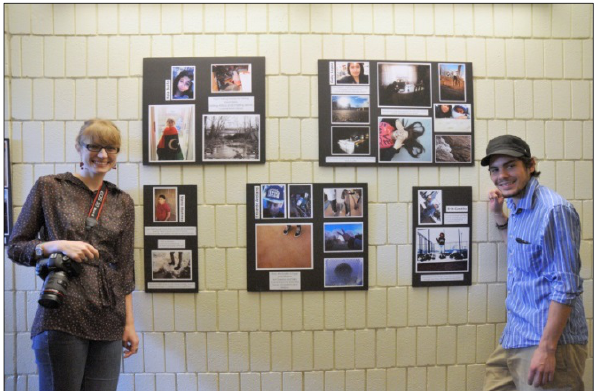
Figure 12. Youth Services Initiative (YSI) photovoice facilitators, a professional photographer and GUB undergraduate intern from the Program in Environmental Design at the University of Colorado, posing with youth photos (photo courtesy Lynn M.